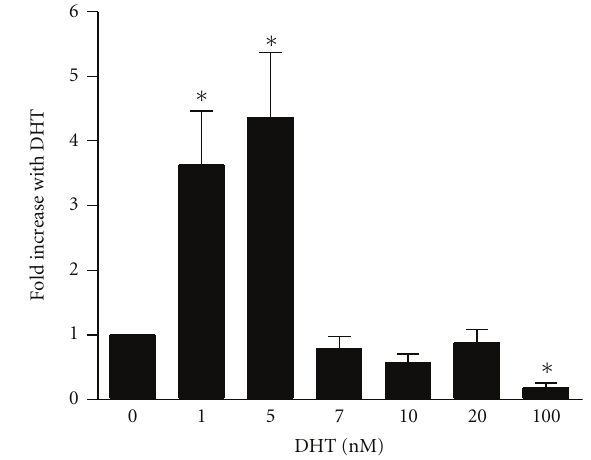
Figure 1: Endogenous ZEB1 mRNA expression is induced by DHT . PC-3/AR cells were treated with vehicle (0nM) or increasing amounts of DHT as indicated. Twenty-four hours later, RNA was harvested and subjected to qPCR using the ZEB1 and RPL32 primers listed in Table 1. ZEB1 mRNA levels were normalized to RPL32 and then plotted relative to the no DHT control. This experiment was repeated 6 times in triplicate. The errors bars represent the standard deviation from the mean average of all experiments. ∗ P < 0 . 05 compared to no